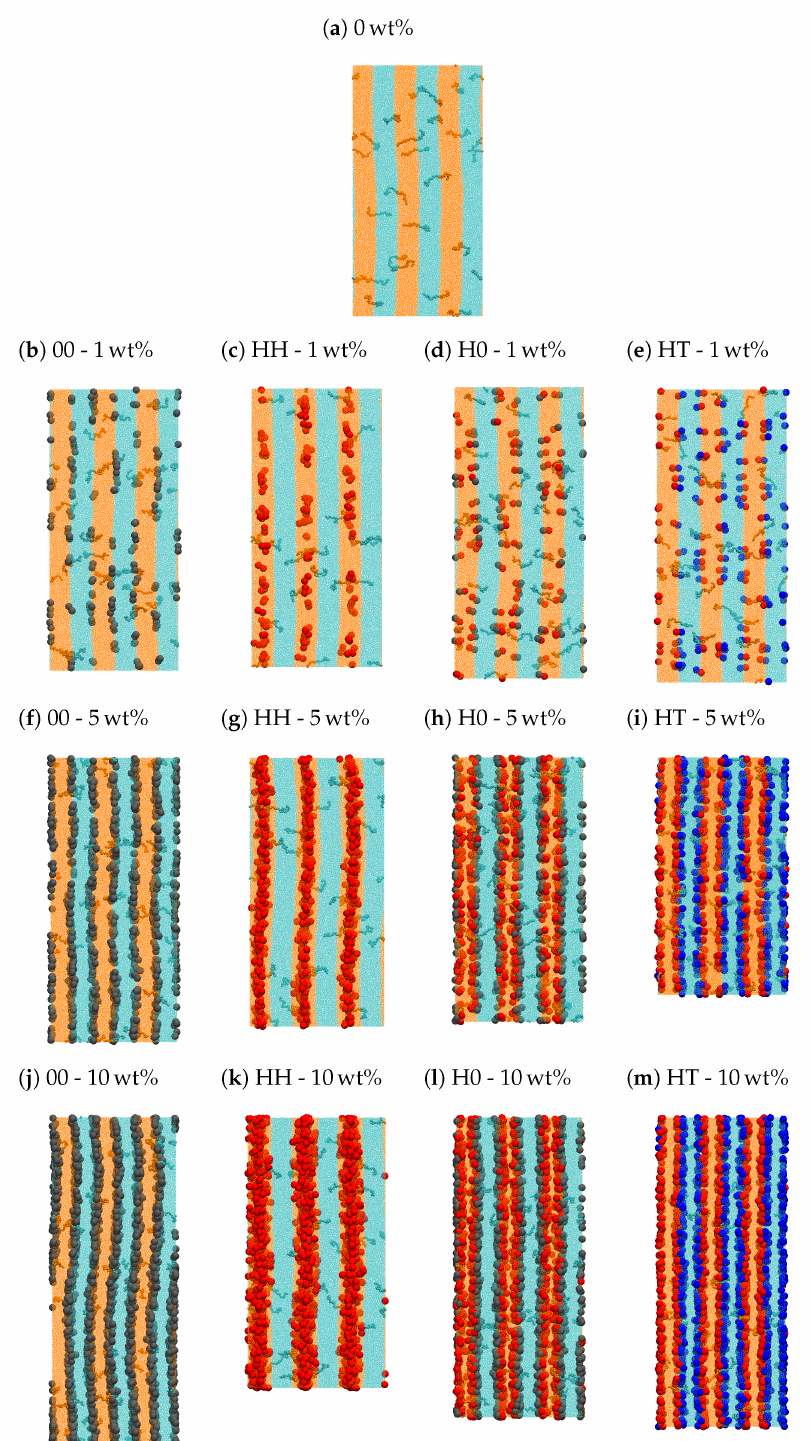
Figure 4. Frontal view of typical equilibrated configurations of the model PNCs studied in this work. NDs’ monomers are shown as spherical beads. Most polymer chains are depicted as points for clarity. However, some of them are magnified to better appreciate their conformations across the interface. Different colours indicate h-block (orange), t-block (cyan), neutral (grey), head-like (red) and tail-like (blue) monomers. Subfigures a to m are each identified by ND type and ND mass fraction, as detailed in Table